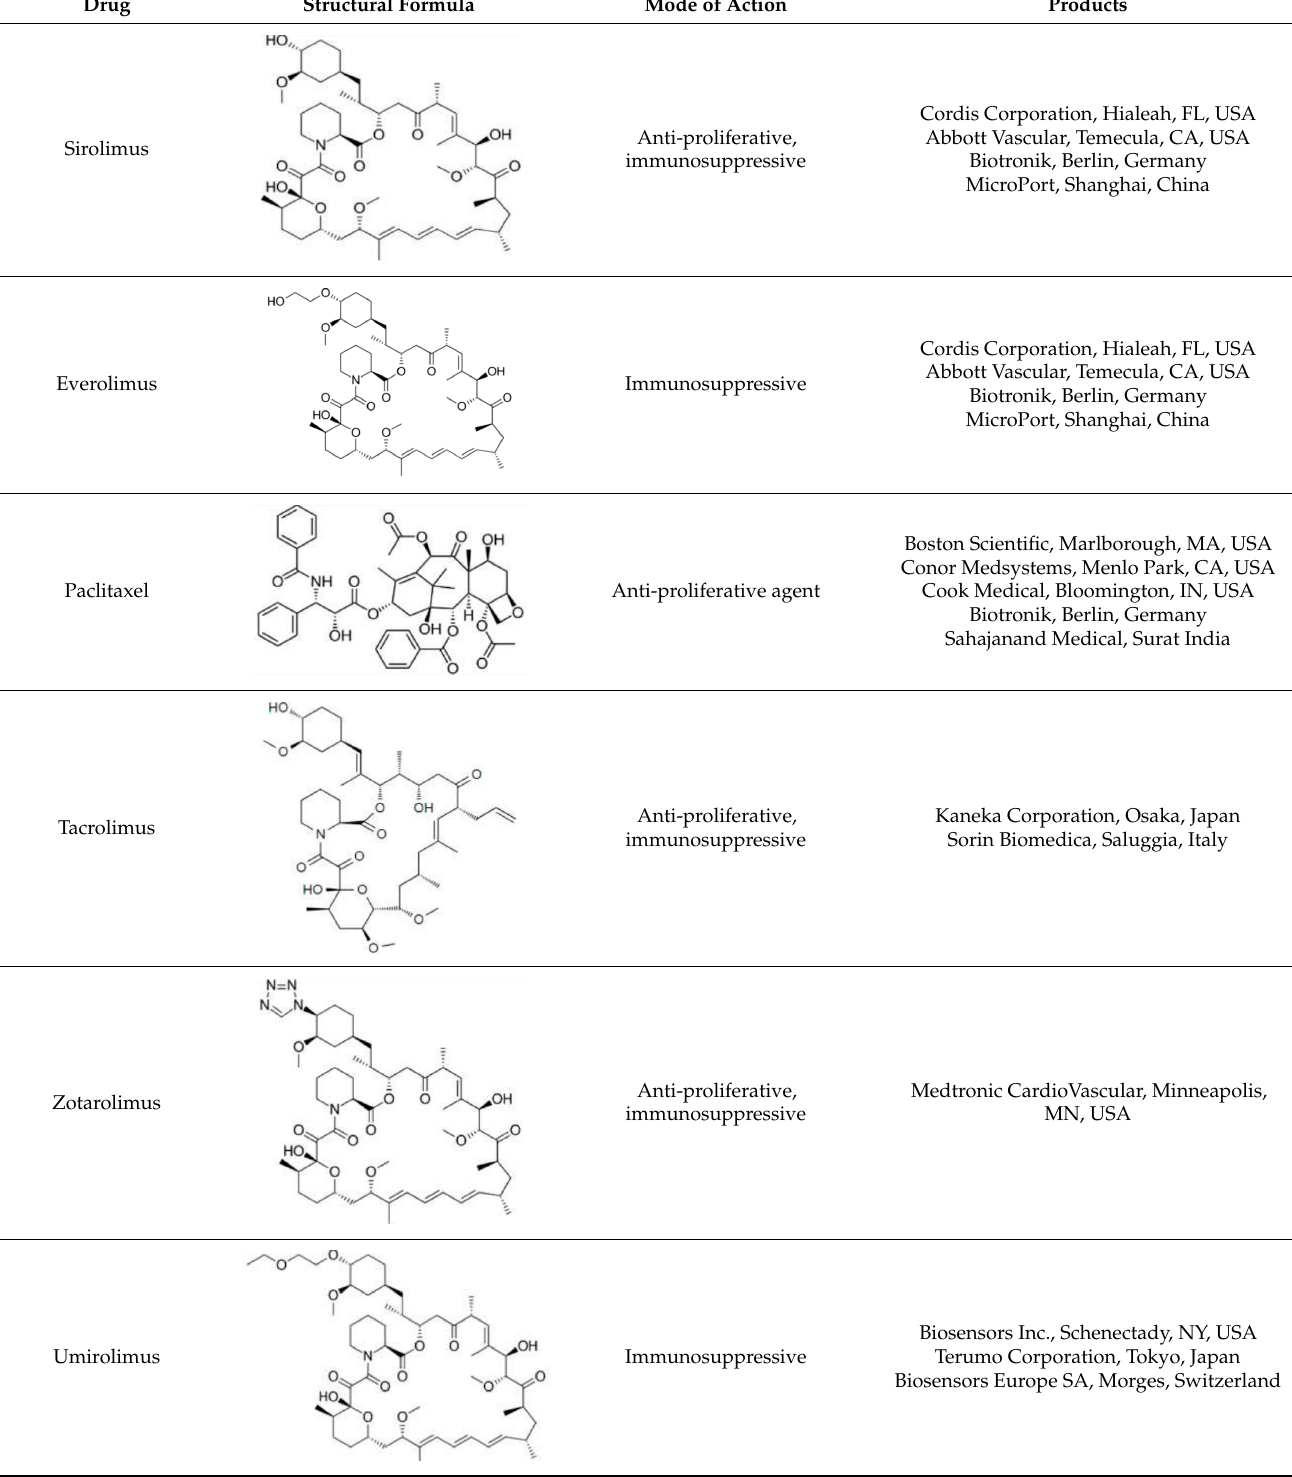
Table 2. Drugs commonly used in a vascular stent.